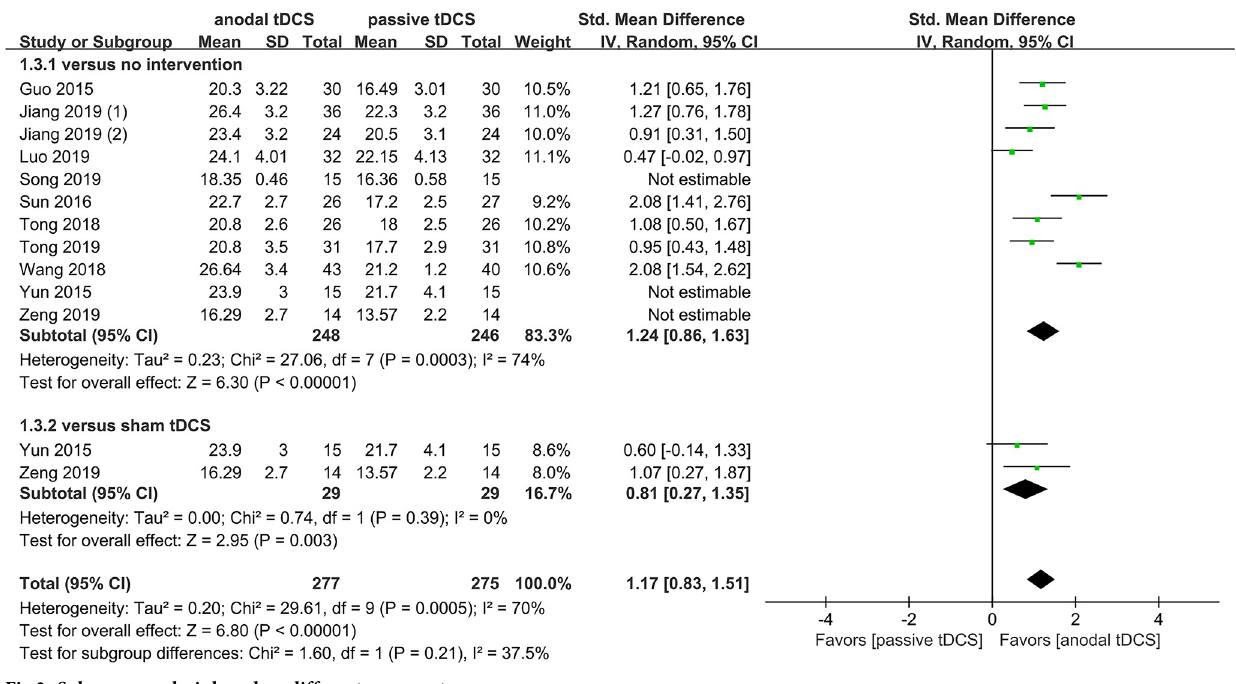
Fig 3. Subgroup analysis based on different comparators.